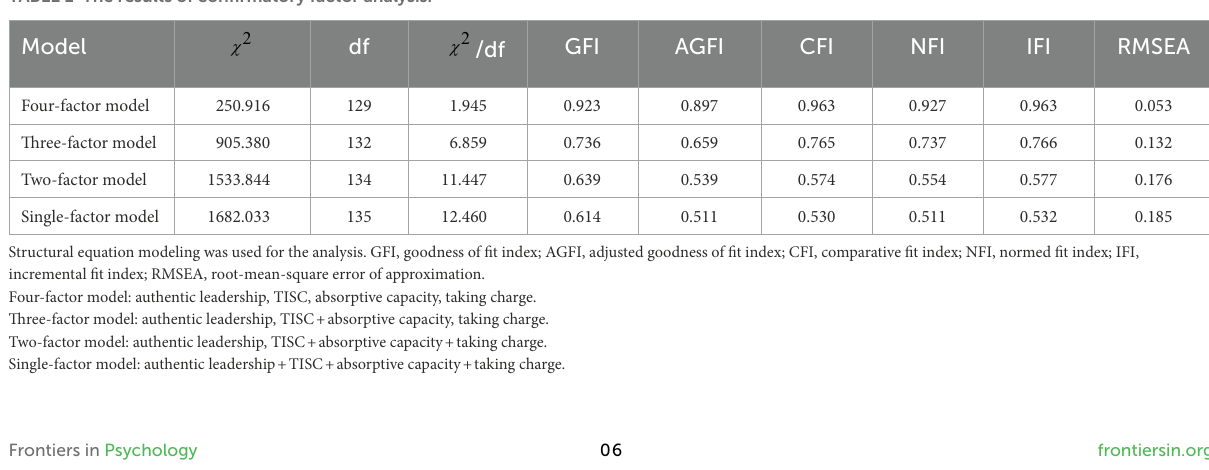
TABLE 1 The results of confirmatory factor